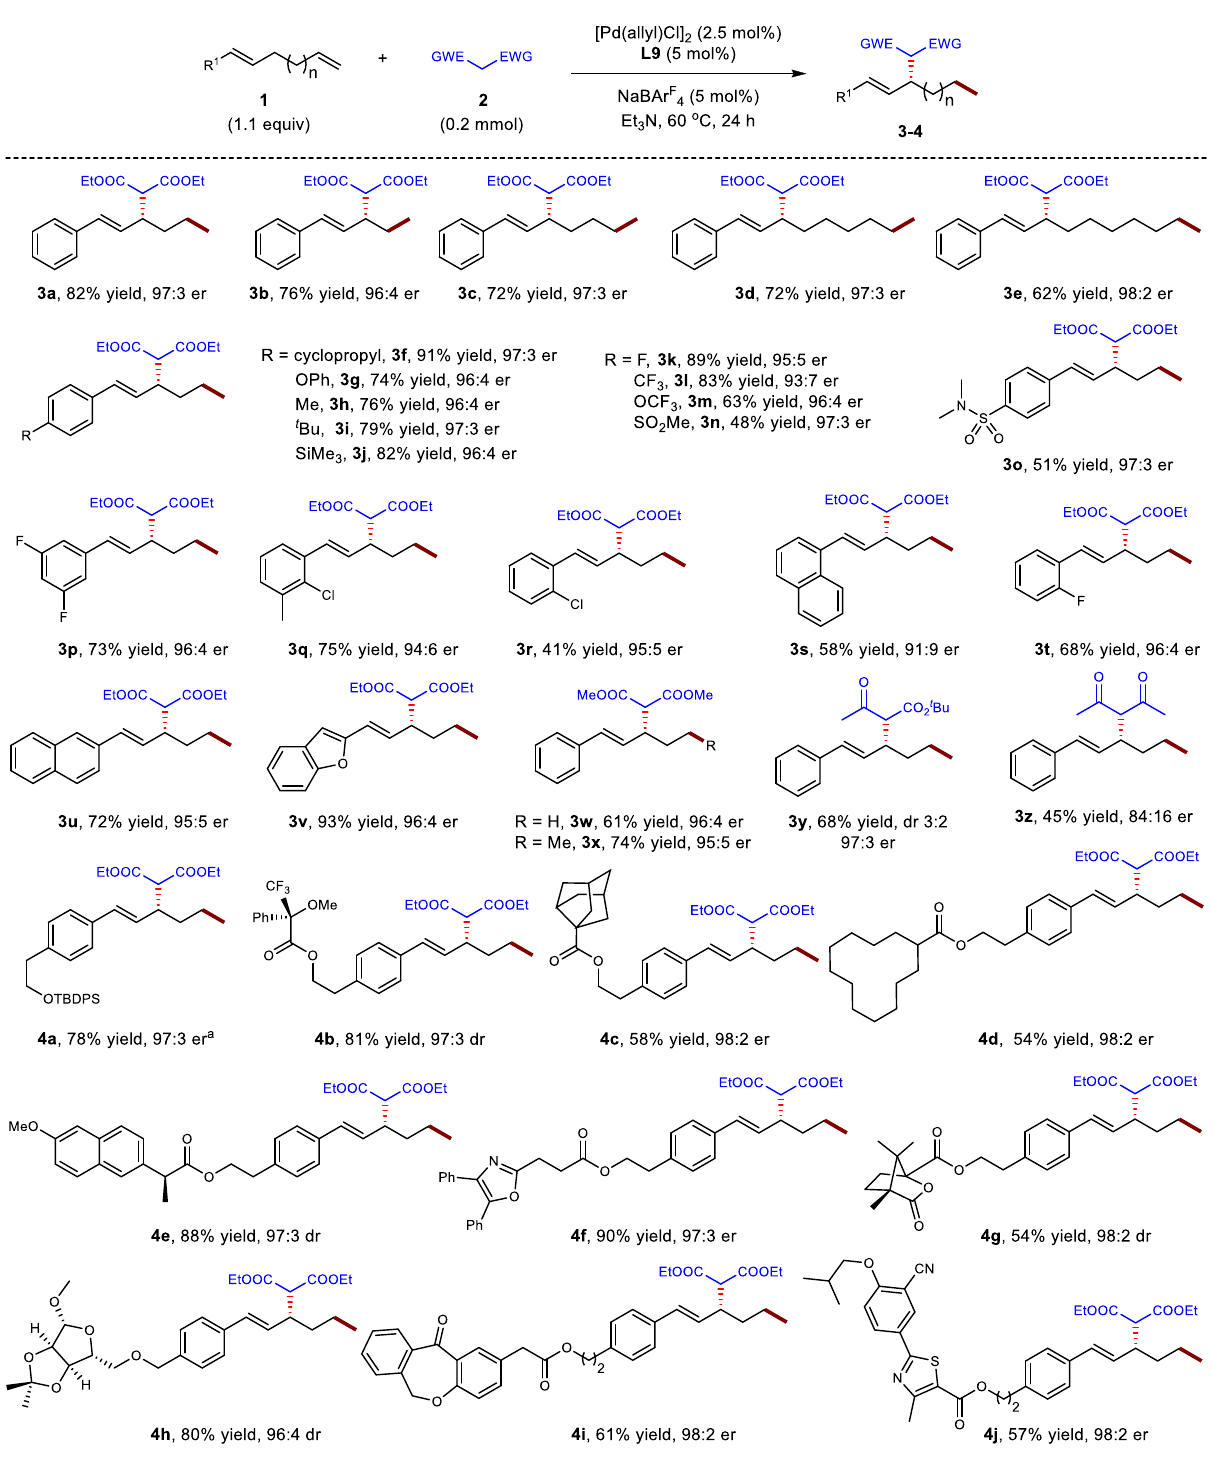
Fig. 3 Scope of the substrates that undergo migratory allylic substitution. The reactions were run with 1 (0.22 mmol), 2 (0.2 mmol), [Pd(allyl)Cl] 2 (2.5 mol%), L9 (5 mol%), NaBAr F 4 (5 mol%) in Et 3 N (0.2 mL) at 60 o C for 24 h. EWG, electron-withdrawing group. a The er value was determined by the HPLC analysis of the desilyl derivative of 4a